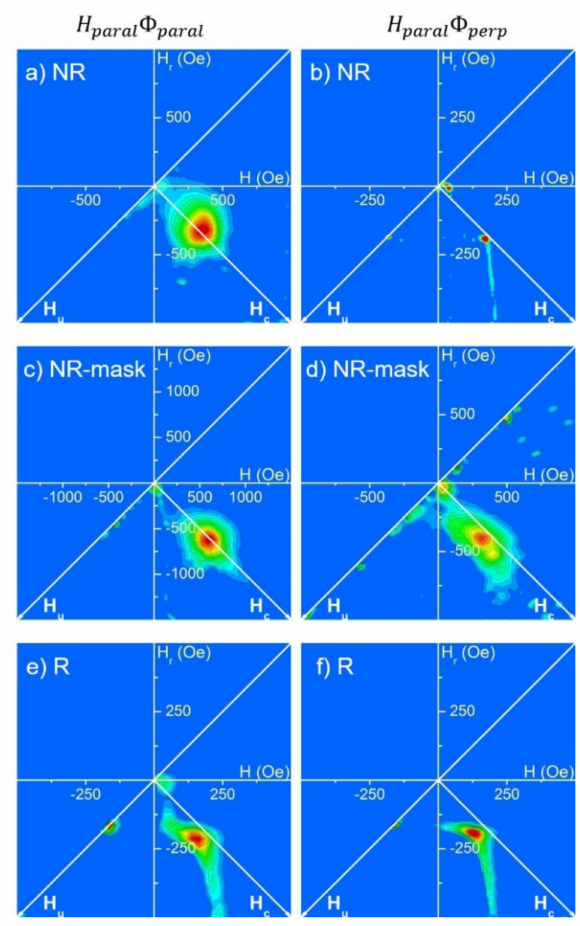
Figure 5. FORC distributions measured with the in-plane magnetic field parallel to the atomic flux ( H paral Φ paral , left column) and perpendicular to it ( H paral Φ perp , right column) for: ( a ) and ( b ) NR sample; ( c ) and ( d ) NR-mask sample; and ( e ) and ( f ) R